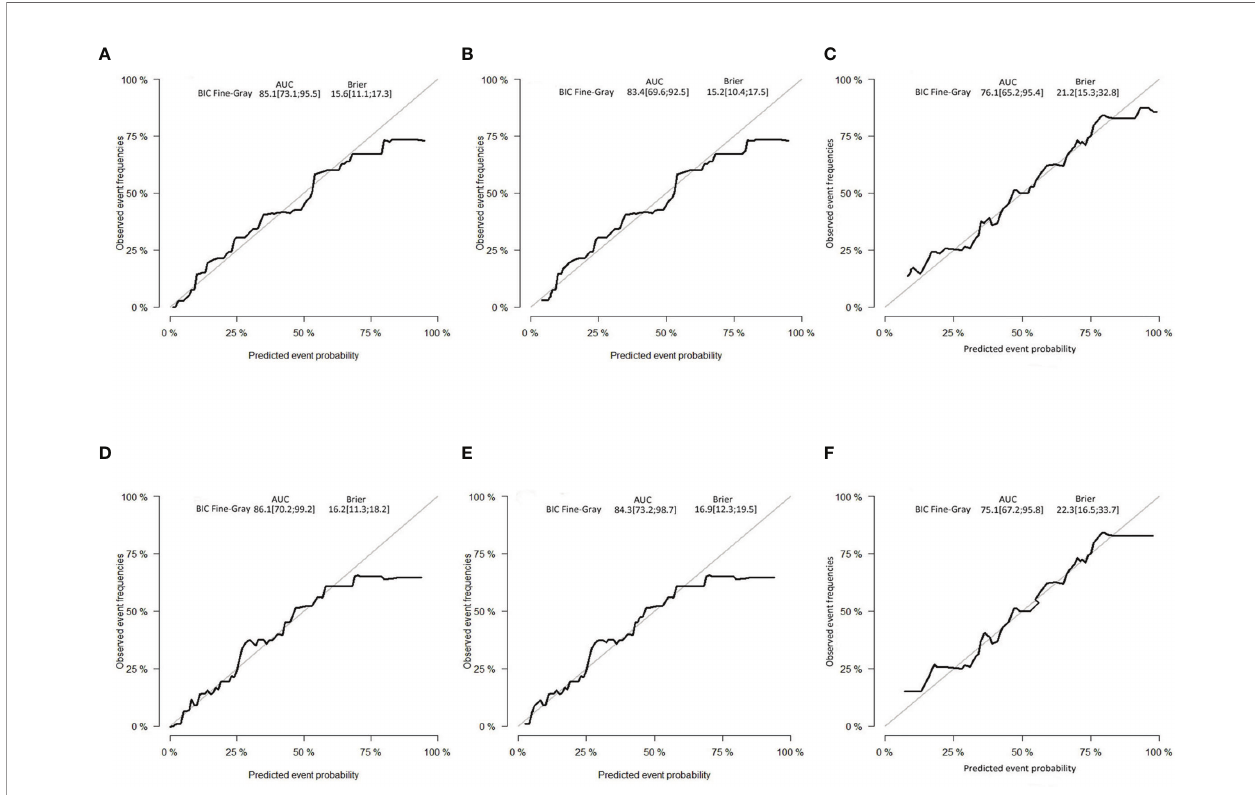
FIGURE 5 | Calibration curves. (A) Three-year and (D) 5-year likelihoods of CSD in the test dataset. (B) Three-year and (E) 5-year likelihoods of CSD in the internal veri fi cation dataset. (C) Three-year and (F) 5-year likelihoods of CSD in the external veri fi cation dataset. BIC, Bayesian information criterion; AUC, area under the